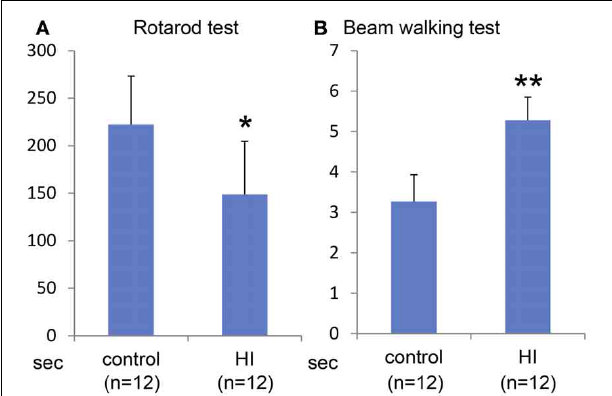
FIGURE 2 | Behavioral evaluation at 3 weeks after HI insult. Rotarod test (A) and Beam walking test (B) show that somatomotor function disorder in the HIE model mice compared to control group with statistical significance ( ∗ P < 0 . 05, ∗∗ P < 0 . 001).